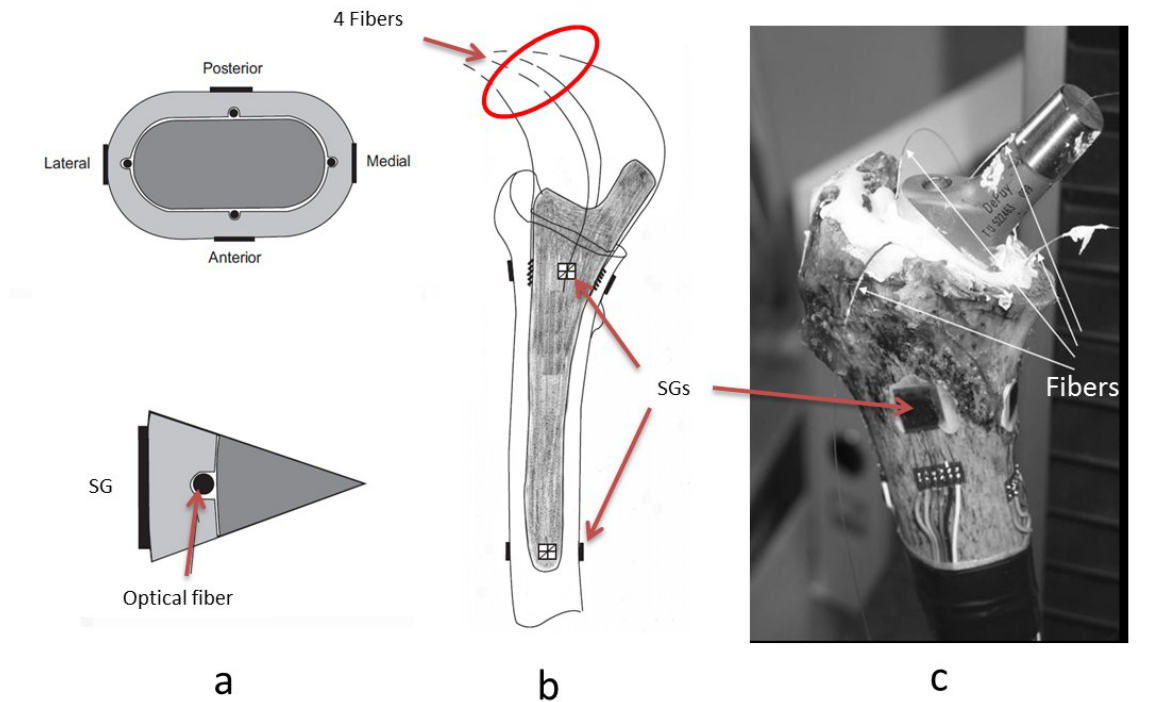
Figure 4. Schematic of the experimental set-up. ( a ) A cross-section of the implanted femur, showing the locations of FBGs and SGs. ( b ) Schematic drawing of the femur with cemented prosthesis, showing the internal (optical fibers) and external (SGs) positions of sensors at the proximal and distal levels. ( c ) Image of the experimental set-up of an implanted cadaveric femur